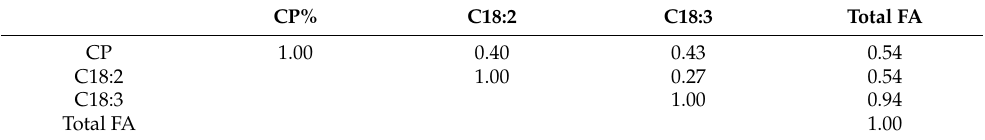
Table 3. Correlation between crude protein (CP), total fatty acids (FA), linoleic acid (C18:2), and α -linolenic acid (C18:3) in grasses, legumes, and forbs ( n = 182) (12, 18, 26, 28, 37, 38). CP% C18:2 CP